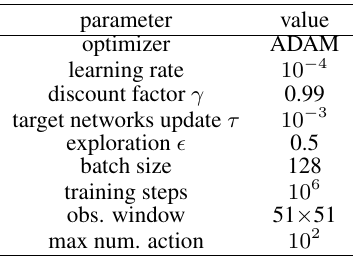
Table 1. Parameters used in